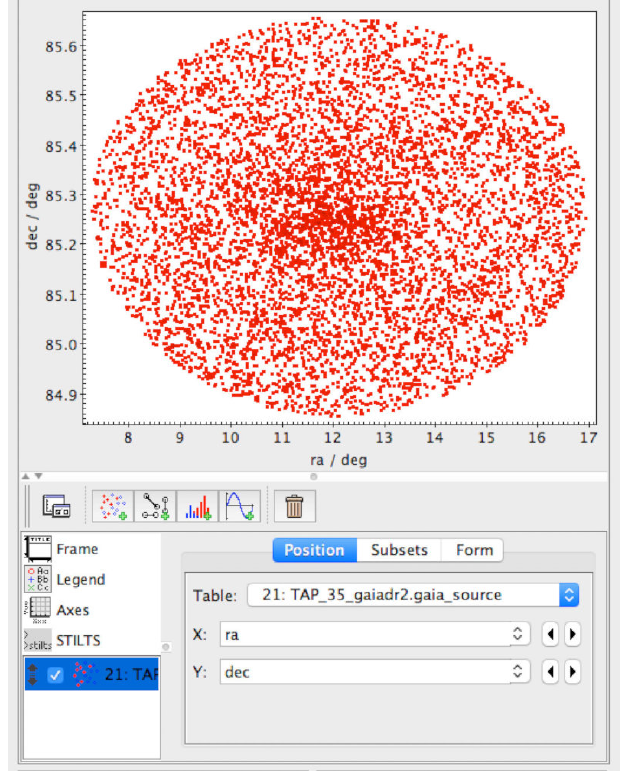
Fig. 62.— RA-Dec plot of the region around NGC 188